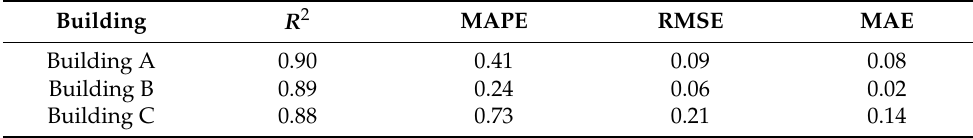
Figure 10. The prediction results of LSTM in building B and building C. Table 4. Evaluation metric results of LSTM in three buildings.